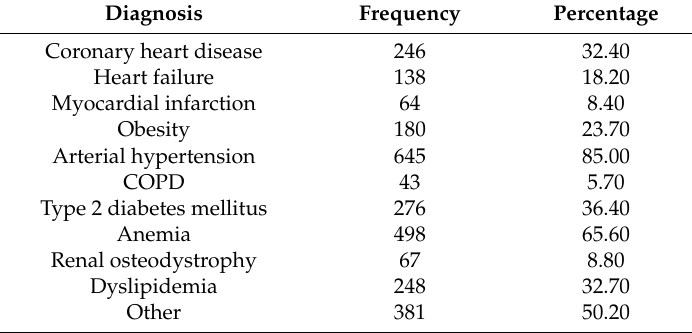
Table 3. Secondary diagnoses.